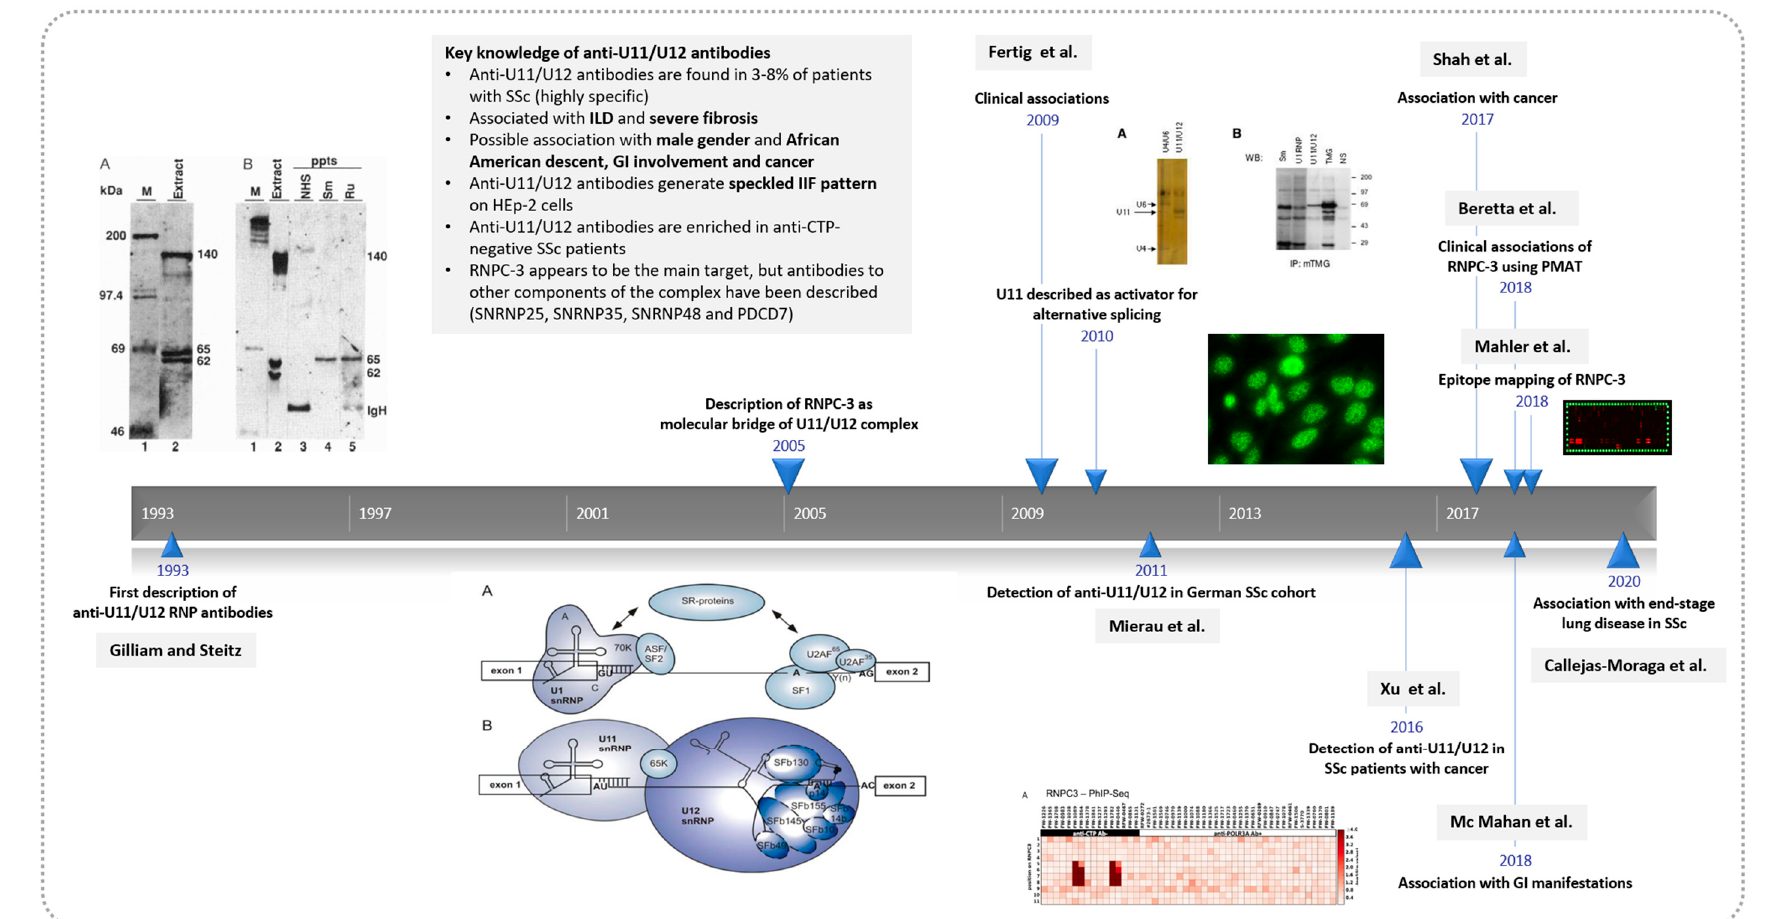
Figure 1. History of anti-U11/U12 RNP autoantibodies. The history of anti-U11/U12 RNP antibodies started in 1993 with the discovery of the antibodies by Gilliam and Steitz [22]. During the following years, several studies focused on the molecular aspects and cellular function of the U11/U12 RNP complex. It was not until 2009 when Fertig et al. [36] added to the knowledge of clinical associations of anti-U11/U12 RNP. Later on, Shah et al. first reported on a potential association with cancer and McMahan et al. [37] with gastrointestinal involvement. Other key studies on anti-U11/U12 RNP antibodies are included [29,33,34,38,39].